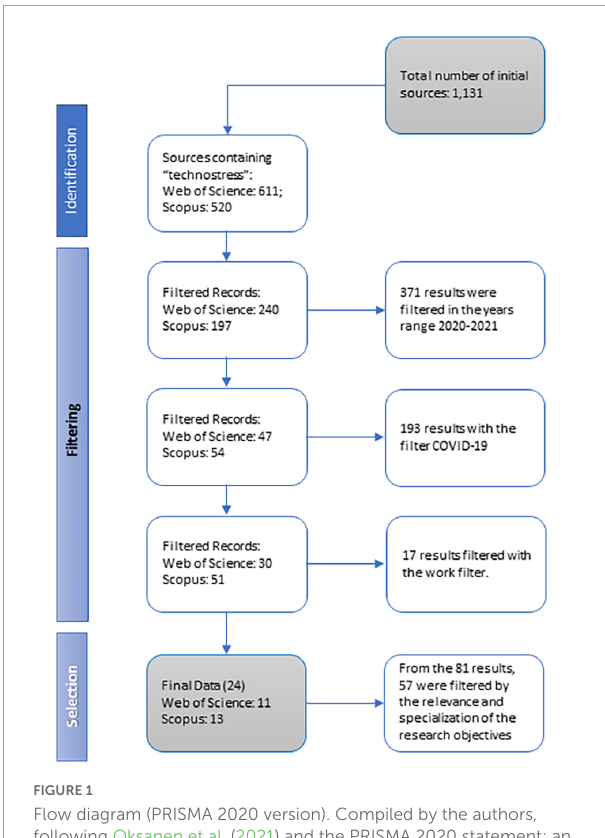
FIGURE1 Flow diagram (PRISMA 2020 version). Compiled by the authors, following Oksanen et al. (2021) and the PRISMA 2020 statement: an updated guideline for reporting systematic